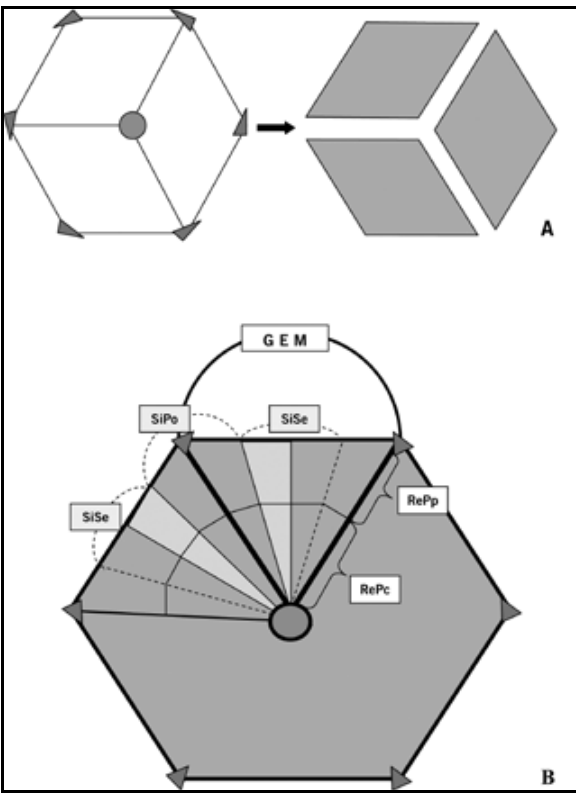
relação com o lóbulo